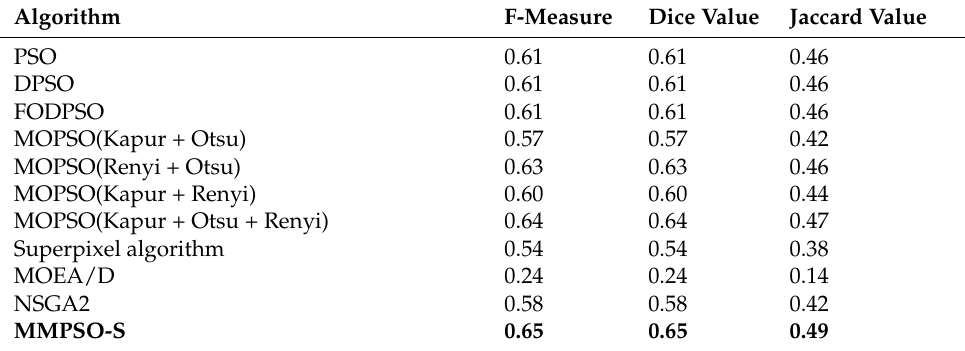
Table 5. Segmentation results of TNBC